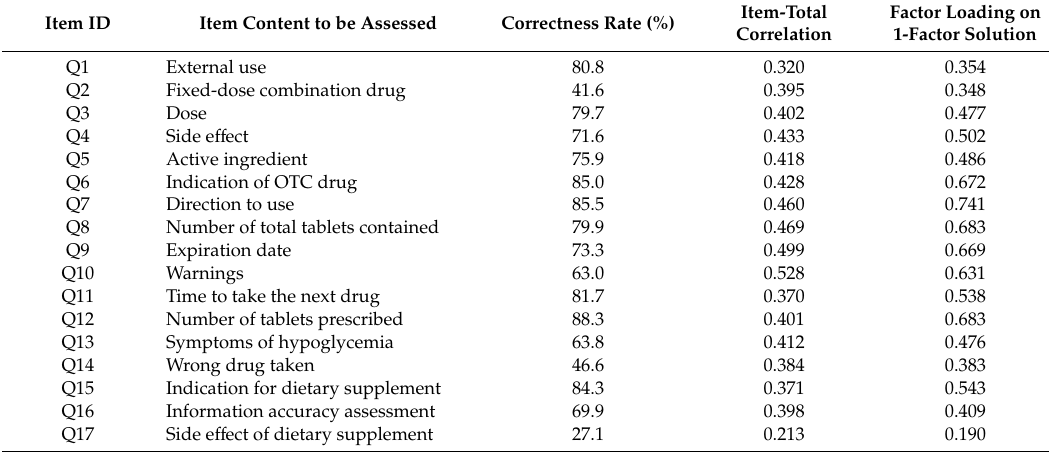
Table 2. Psychometric properties of items in the ChMLM-17 based on the 1410